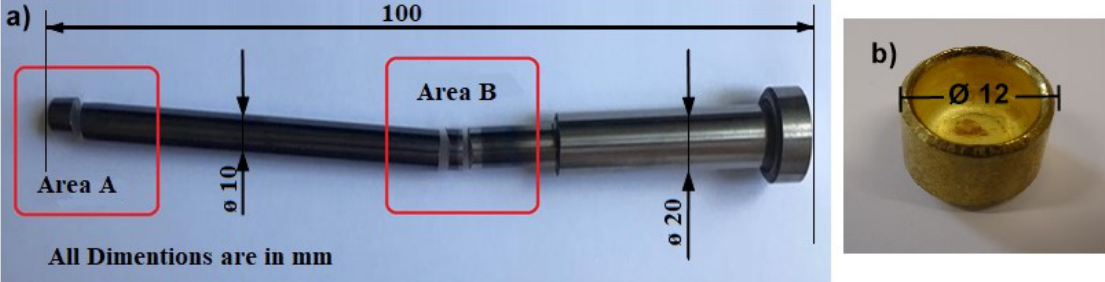
Figure 1. Deep drawing tool ( a ) for production of cartridges ( b ).